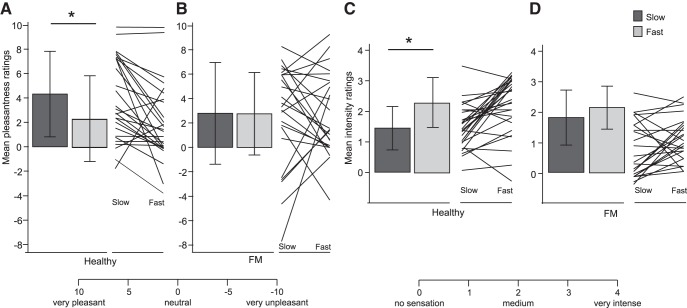
Pleasantness and intensity of brushing in healthy participants and chronic pain patients. Healthy participants and FM patients rated the pleasantness (A, B) and intensity (C, D) of slow (CT-optimal) and fast brushing of the left forearm on the corresponding VAS scales. Mean ratings at baseline (before any drug administration) are displayed; error bars show SD. *Two-tailed Tukey test, p < 0.05. Lines display individual participant data. There was a significant main effect of brushing speed (slow vs fast) on pleasantness ratings (F(1,50) = 3.56, one-tailed p = 0.032 a; without males: F(1,46) = 3.76, one-tailed p = 0.027) but no main effect of group (healthy vs FM; F(1,50) = 0.41, one-tailed, p = 0.26 b; without males: F(1,46) = 0.32, one-tailed, p = 0.26). There was a significant interaction between brushing speed and group (F(1,50) = 3.32, one-tailed, p = 0.037c; Cohen’s d = 0.51; without males: F(1,46) = 3.14, one-tailed, p = 0.04; A shows mean slow–fast ratings). Post hoc Tukey tests showed that healthy participants rated slow brushing as significantly more pleasant than fast brushing (Tukey, p = 0.042), whereas FM participants did not (Tukey, p = 1.00; A shows mean slow–fast ratings). Age did not affect ratings of brushing pleasantness or interact with speed in healthy participants (F(1,26) = 0.03, p = 0.86d; F(1,26) = 0.09, p = 0.76e) or in FM patients (F(1,22) = 0.56, p = 0.46f; F(1,22) = 3.08, p = 0.09g). When depression and anxiety were added to the model, depression significantly predicted pleasantness ratings (F(1,46) =4.28, p = 0.04); anxiety did not (F(1,46) = 0.42, p = 0.52). Including these ratings in the model strengthened the group by speed interaction (F(1, 48) = 4.42, two-tailed, p = 0.041). There was a significant main effect of speed of brushing (slow vs fast) on intensity ratings (F(1,50) = 4.26, p < 0.001h; without males: F(1,46) = 20.0, p < 0.001) but no main effect of group (healthy vs FM; F(1,50) = 0.32, one-tailed, p = 0.58 i; without males: F(1,46) = 0.19, two-tailed p = 0.67). There was a significant interaction between brushing speed and participant group (F(1,50) = 4.26, p = 0.044 j; Cohen’s d = 0.57; without males: F(1,46) = 4.42, p = 0.041,). Post hoc Tukey tests showed that healthy participants rated fast brushing as more intense than slow brushing (Tukey p < 0.001), whereas FM participants did not (Tukey p = 0.24; B shows mean slow–fast ratings). Age did not affect ratings of brushing intensity or interact with speed in either healthy participants (F(1,26) = 1.09, p = 0.31k; F(1,26) = 0.11, p = 0.75l) or FM patients (F(1,22) = 0.01, p = 0.93m; F(1,22) = 0.05, p = 0.83n). Anxiety significantly predicted pleasantness ratings (F(1,46) = 6.66, p = 0.01); depression did not (F(1,46) = 1.34, p = 0.25). Including these ratings in the model weakened the group by speed interaction (F(1,48) = 3.67, two-tailed p = 0.061).